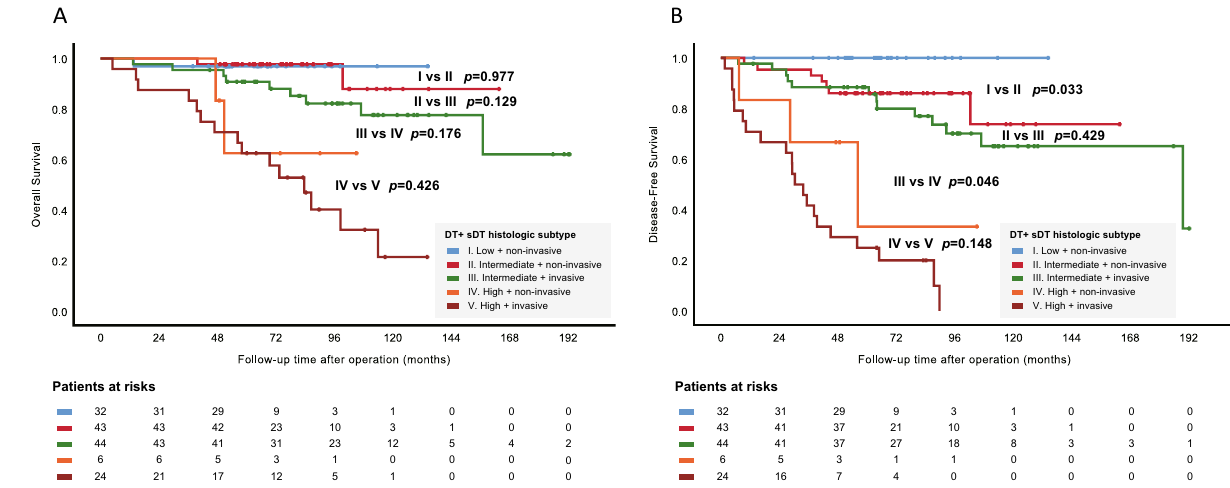
Figure 4. Overall ( A ) and disease-free ( B ) survival between different histologic subtyping combinations.